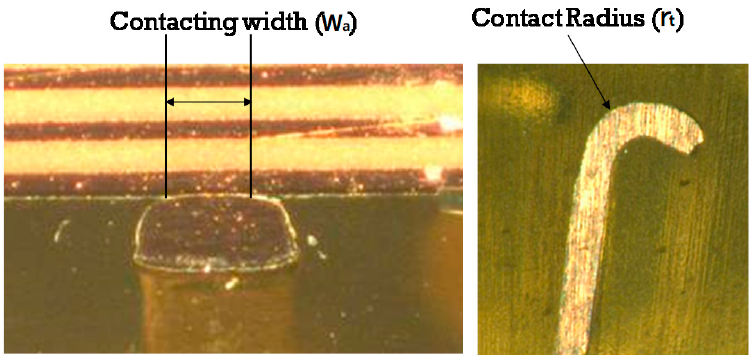
Figure 14. Contacting width and contact tip radius